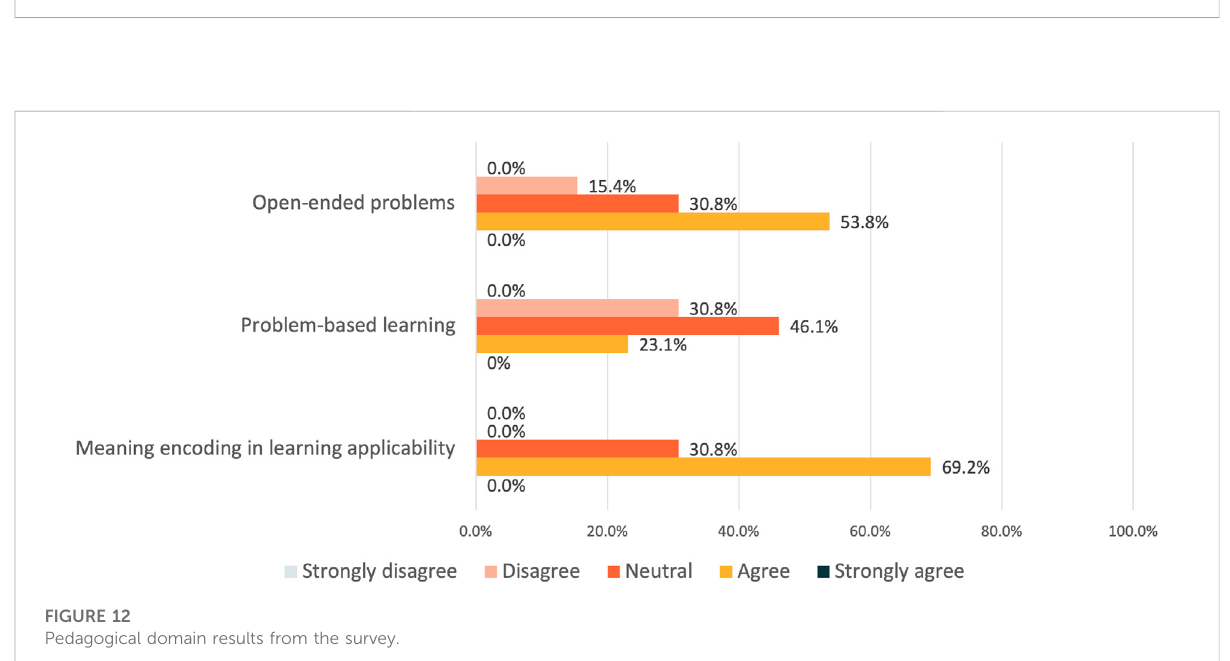
FIGURE 12 Pedagogical domain results from the